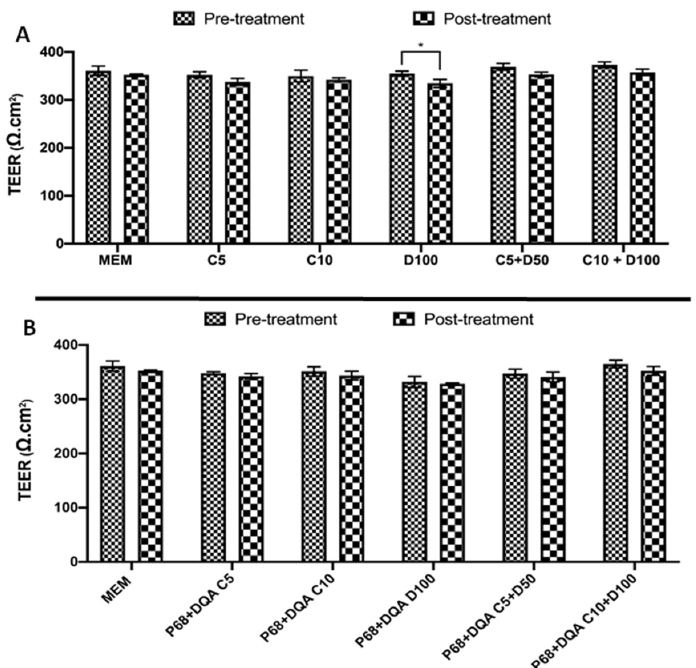
Figure 2. ( A ) Mean TEER of hCMEC/D3 cell monolayers on day 3 post seeding before (pre-treatment) and after (post-treatment) treatment with free 5 or 10 µ M curcumin (C5 and C10), 100 µ M DFO (D100) or the combination of 5 µ M or 10 µ M curcumin with 50 µ M or 100 µ M DFO (C5 + D50 and C10 + D100, respectively). ( B ) Corresponding TEER results pre- and post-treatment with P68 + DQA nanoformulations of curcumin, DFO and combined curcumin and DFO. * represents significance values when comparing the pre- and post-treatment TEER values for a given treatment condition (* p < 0.05).